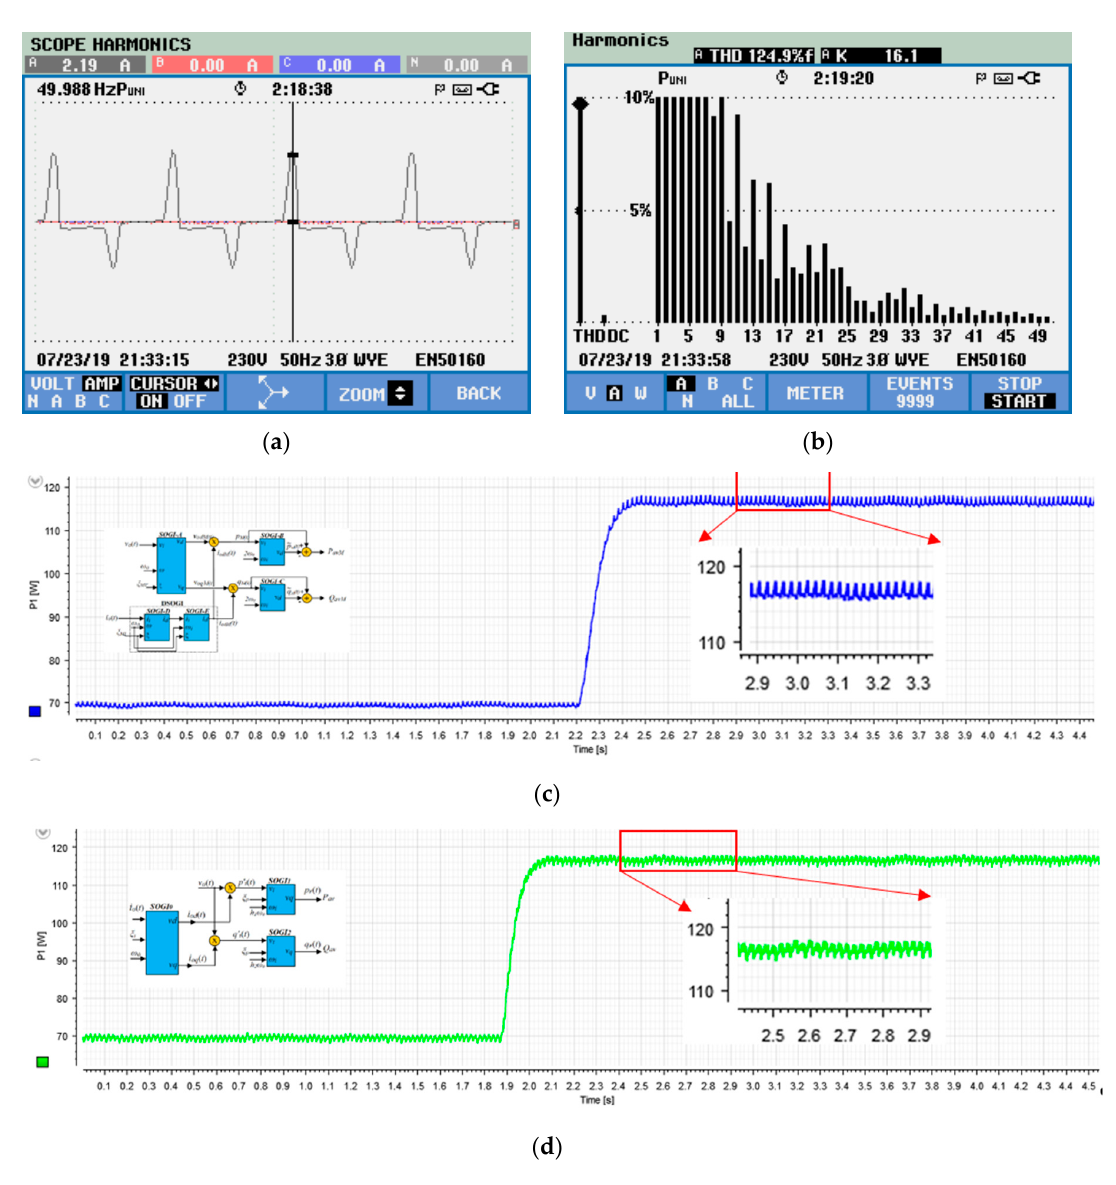
Figure 15. ( a ) Measured current at point of common coupling (PCC) through Fluke Power Analyzer, configured to single-phase employing Channel A; ( b ) THD of the measured current, calculated using Fast Fourier Transform; ( c ) PavM Active power calculation and dynamic performance during an abrupt load change, as well as its detail for the steady-state ripple; ( d ) proposed Pav Active power calculation and dynamic performance during an abrupt load change, as well as its detail for the steady-state ripple. Table 8. Simulation, HIL, and experimental results for active power.